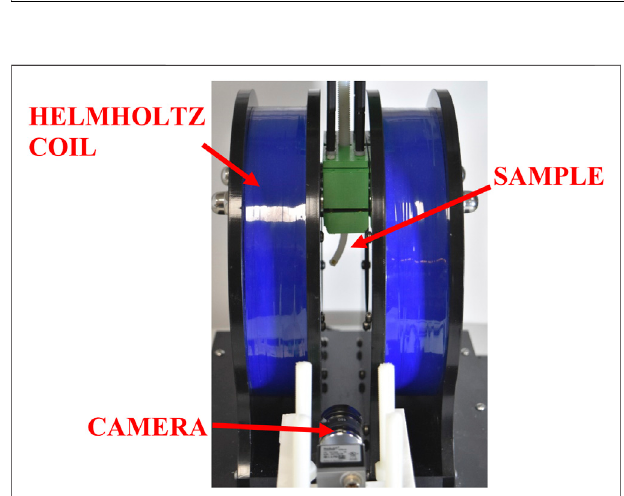
FIGURE4 | Experimental setup for testing magnetic robots. Thesample is mounted in the center of the Helmholtz Coil and the de fl ection is captured using a side-view